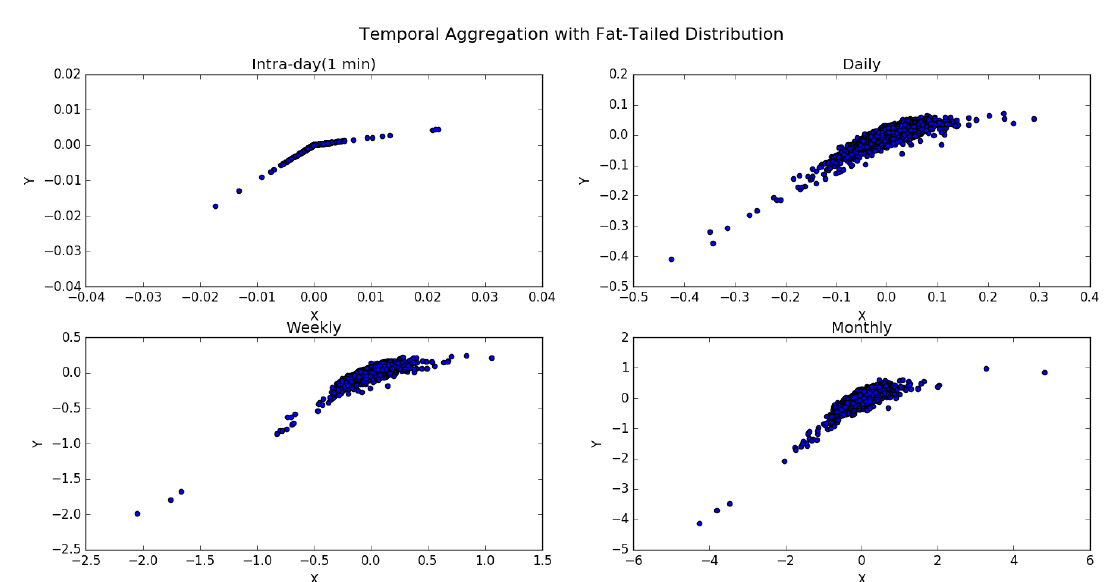
Figure 4. Temporal Aggregation with Normal Distribution.